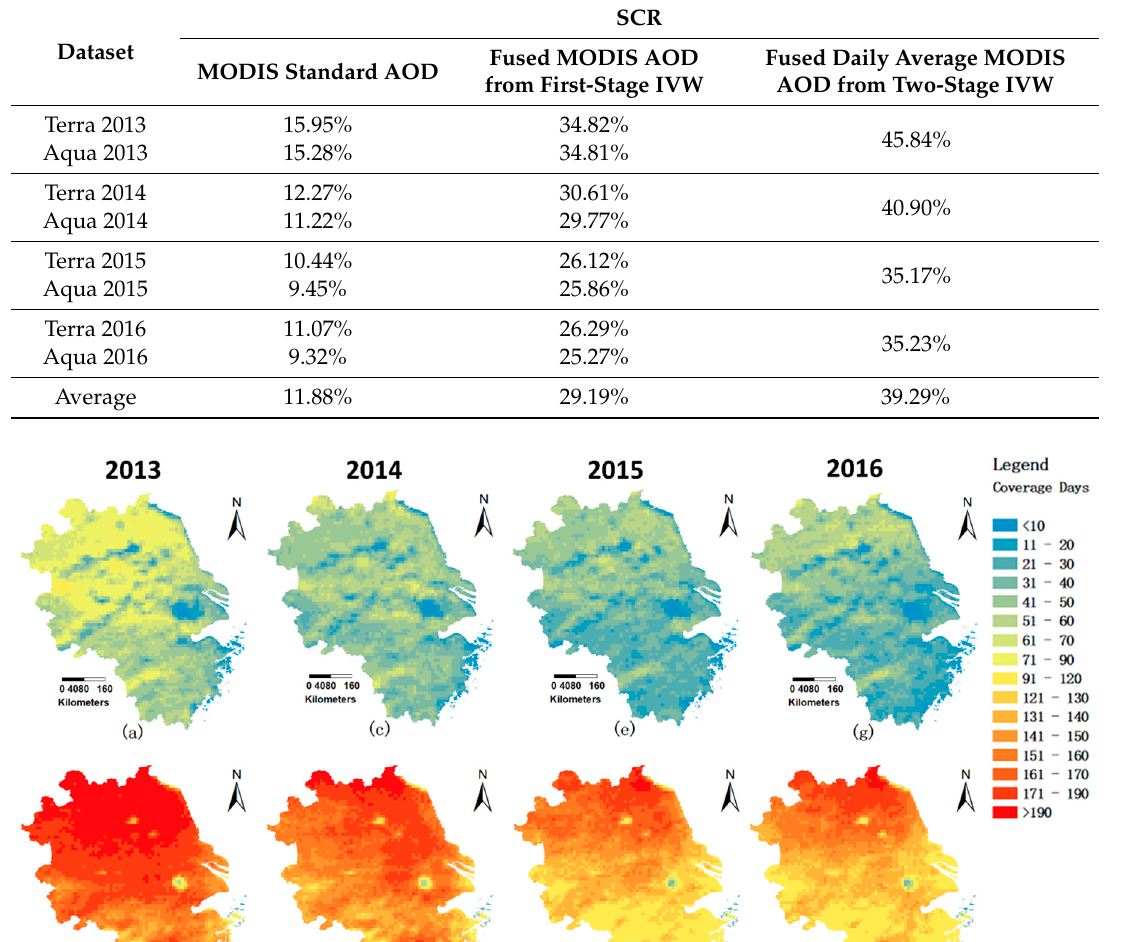
Table 3. Comparison in spatial coverage rate (SCR) among MODIS standard AOD, fused daily AOD from first-stage IVW and from two-stage IVW.